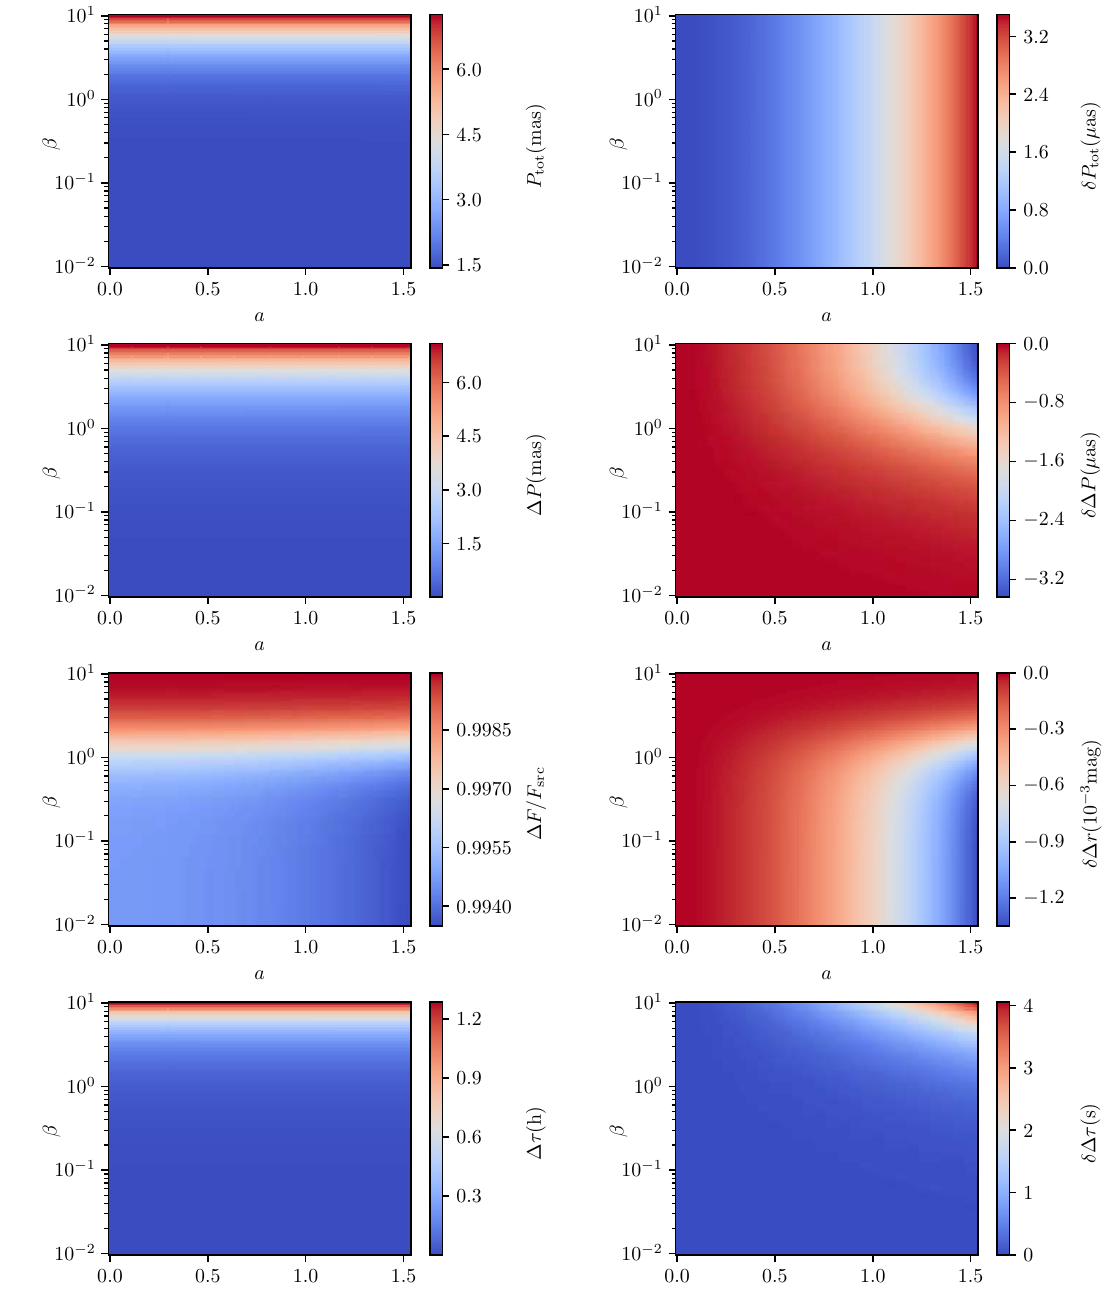
Fig. 2 Color-indexed practical observables in the weak deflection gravitational lensing by the quantum deformed Schwarzschild black hole and their deviations from those of the Schwarzschild black hole are showed with respect to the source position β and the quantum defor-